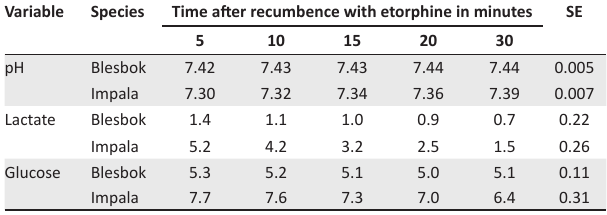
TABLE 1a: Species comparison of arterial blood pH, lactate in mmol/L and glucose in mmol/L over time and standard error during immobilisation, with